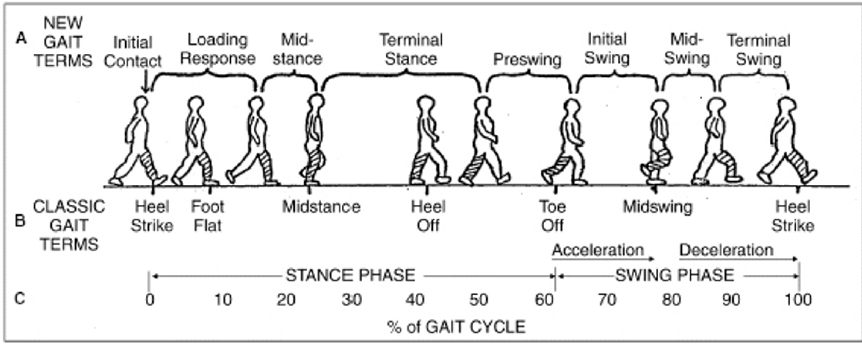
Figure 1. Illustration of different phases of the gait cycle. ( A ) New gait terms; ( B ) classic gait terms; and ( C ) Percentage of gait cycle. Note: this figure is adapted with permission from [16]; Copyright Demos Medical Publishing Inc., 2004.